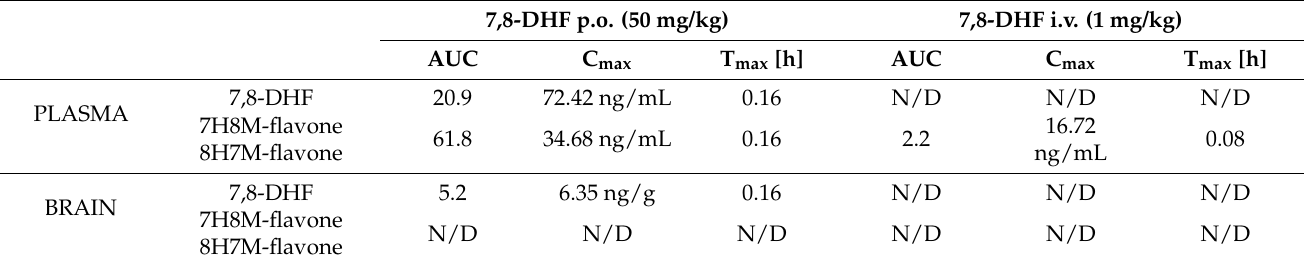
Table 3. Pharmacokinetic parameters determined for 7,8-DHF and its metabolites in mouse brain and plasma after oral (p.o.) and intravenous (i.v.)